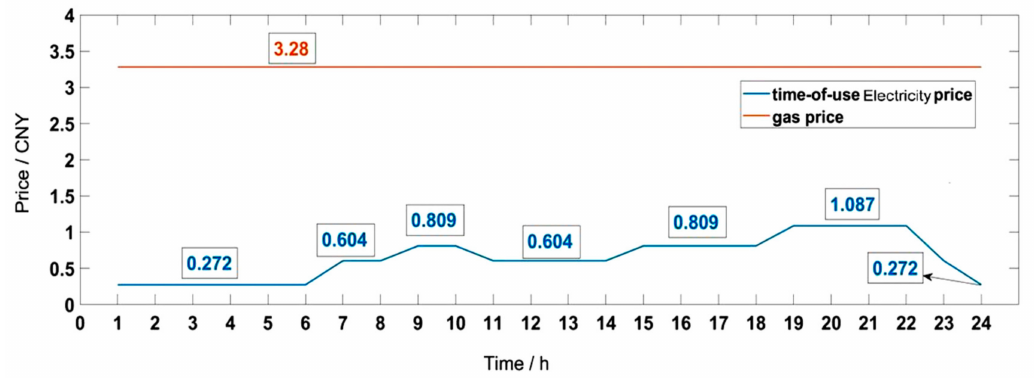
Figure 11. Peak–valley electricity price and gas price.